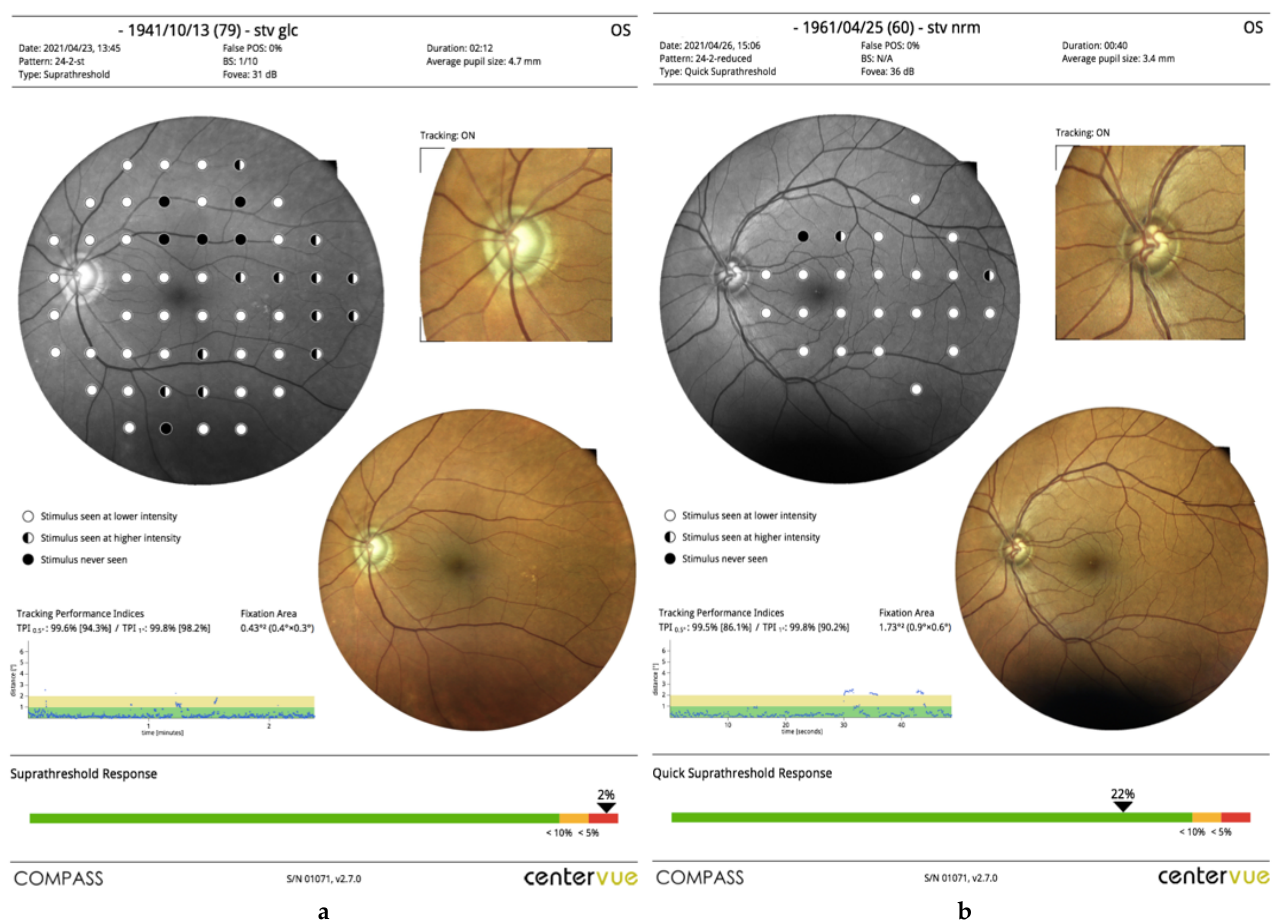
Figure 1. ( a ) This is the printout of SST test. Demographic and reliability data, test time, foveal sensitivity and average pupil size are reported on the top. The main field shows the tested sensitivities superimposed to an infrared image of the central retina; a true-color image of the retina and a detail on optic nerve head are also given. The tracking performance indices are shown. The diagram is useful to inspect the stability of fixation in the course of the test, and the performance of eye movement compensation is given. In the bottom, the suprathreshold response is given using a color scale. ( b ) A printout of QST test is shown. The structure of the printout is identical to SST, apart from a lower number of field locations.